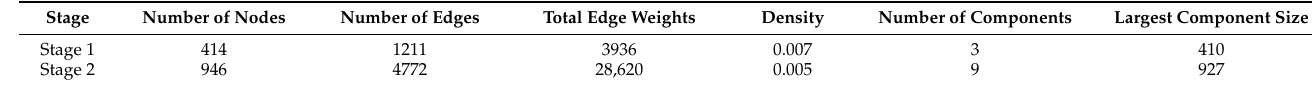
Table 1. Overall characteristics of the media citation